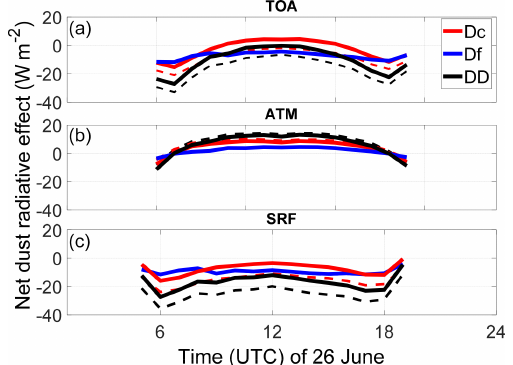
Figure 10. Diurnal cycle on 26 June in BCN of the net dust ra- diative effect (DRE NET ) for Dc, Df and DD (c) at SRF, (b) in the atmosphere, and (a) at TOA. For Dc (red) and DD (black) the diur- nal cycle of DRE SW is also reported by dashed lines. Df DRE SW is not represented since it would overlap with Df DRE NET .